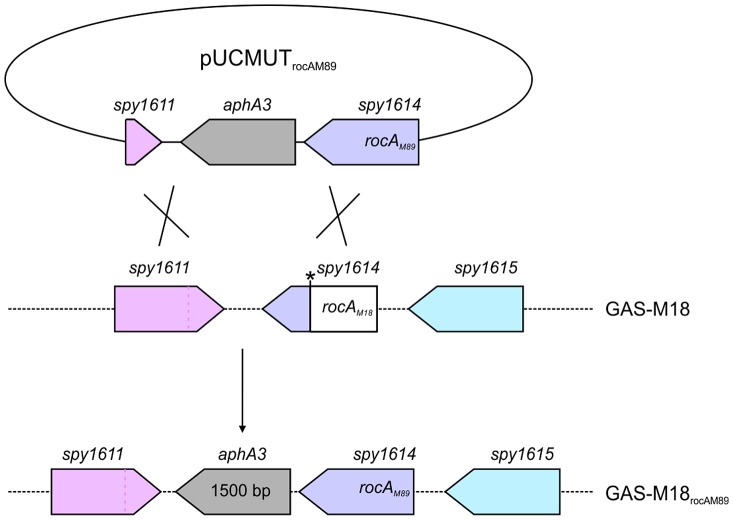
Allelic exchange mutagenesis of rocA
M18 with rocA
M89 in GAS-M18.Correction of the rocA
M18 premature stop codon was achieved by allelic exchange of chromosomal rocA
M18 with rocA
M89 using suicide vector pUCMUT [46]. Double recombination events between rocA (spy1614) and 500 bp region of downstream gDNA including the 3′ end of spy1611 resulted in replacement of rocA
M18 with a single copy of rocA
M89, producing isogenic strain GAS-M18rocAM89. Allelic exchange was confirmed by PCR and sequencing.